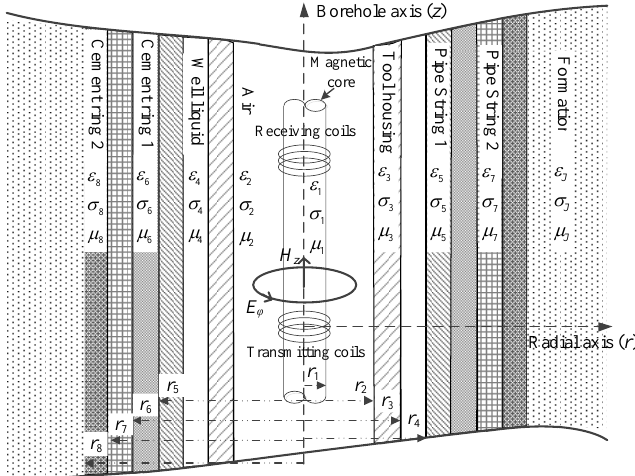
Figure 1. Cylindrically layered structures of a borehole.